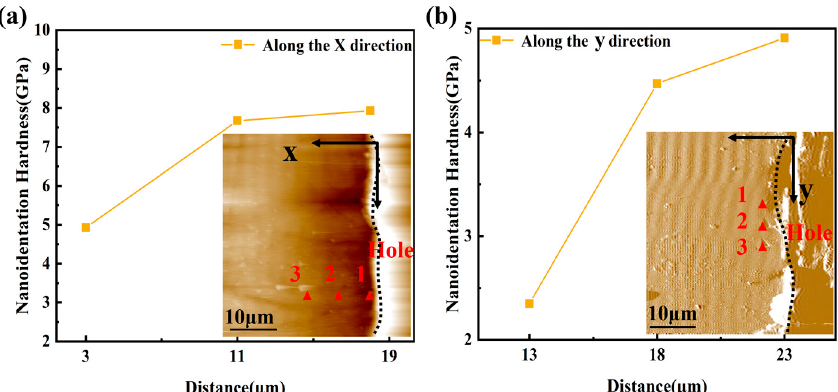
Figure 8. Nanoindentation hardness of the recast layer and matrix at different positions. ( a ) Schematic diagram of nanoindentation hardness and indentation of the recast layer and matrix in the x direction. ( b ) Schematic diagram of nanoindentation hardness and indentation of the recast layer in the y direction. The hardness of the recast layer is much lower than that of the matrix, caused by the lack of precipitation.